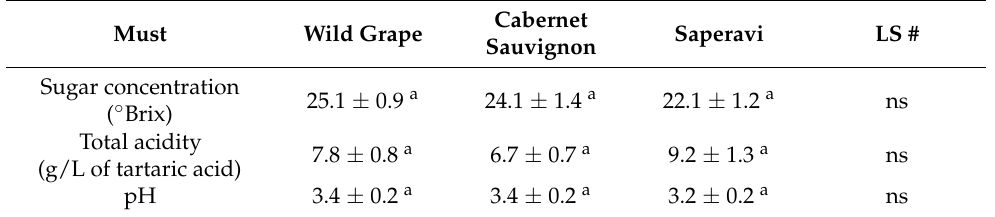
Table 1. Sugar concentration, total acidity, and pH for the musts produced with wild grape, Cab- ernet Sauvignon, and Saperavi grapes. Data is expressed as average ± standard error of the three vintages investigated. Different letters mean significant differences (F-test). #: LS, level of signifi- cance: ns, non-significant.